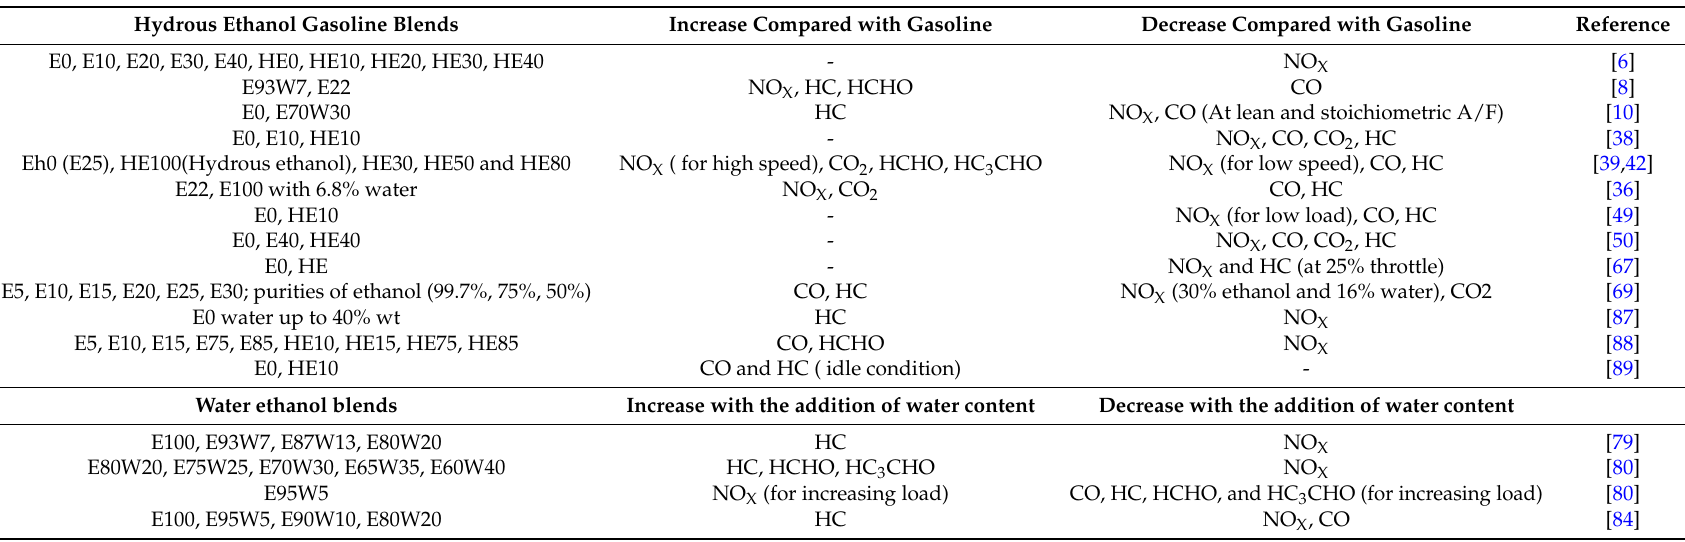
Table 5. Exhaust emission products from hydrous ethanol fuel and its bends with gasoline in SI